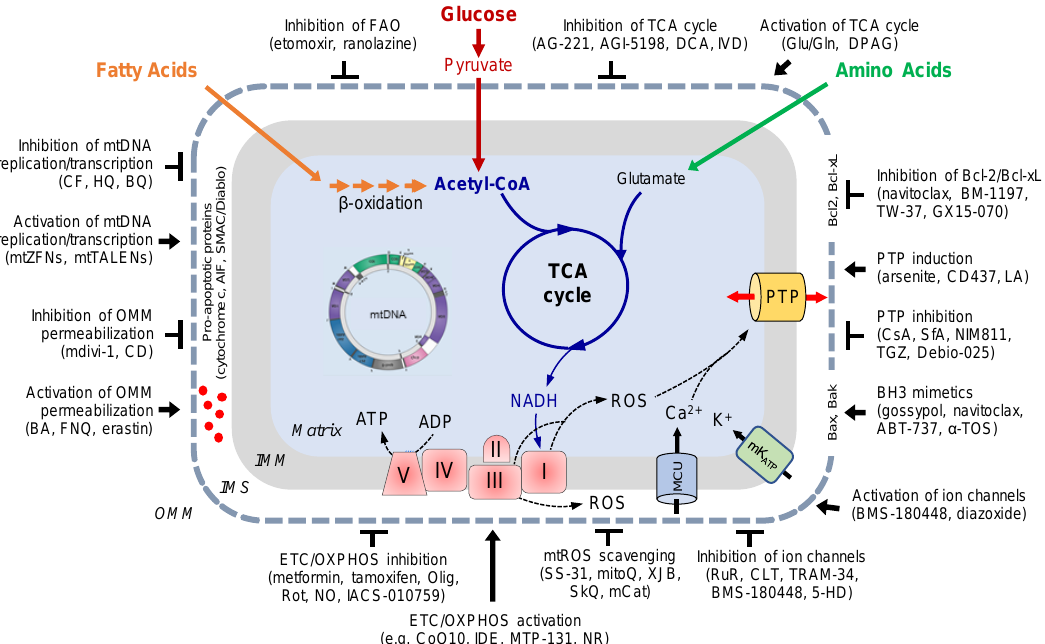
Figure 2. Mitochondria are promising therapeutic target for human diseases. Abbreviations: AIF, apoptosis-inducing factor; BA, betulinic acid; BQ, p-benzoquinone, mCAT, mitochondrial-targeted catalase; CD, chlorodiazepam; CF, ciprofloxacin; CLT, clotrimazole; CsA, cyclosporin A; DCA, dichloroacetate; DPAG, dipyruvyl-acetyl-glycerol; FAO, fatty acid oxidation; FNQ furanonaphthoquinone; 5-HD, 5-hydroxydecanoate; HQ, hydroquinone; Glu/Gln glutmate/glutamine; IDE, idebenone; IMM, inner mitochondrial membrane; IMS, intermembrane space; IVD, ivosidenib; mK ATP , mitochondrial ATP-sensitive potassium channel; LA, lonidamine; MCU, mitochondrial calcium uniporter; NR, nicotinamide riboside; Olig, oligomycin, OMM, outer mitochondrial membrane; PTP, permeability transition pore; Rot, rotenone; RuR, ruthenium red; SfA, sanglifehrin A; mtTALENs, mitochondrially targeted transcription activator like effectors (TALE) fused with a Fok1 nuclease; α -TOS, α -tocopheryl succinate; TGZ, troglitazone; mtZFNs mitochondrially targeted zinc finger nucleases. The names of representative compounds are shown in brackets.